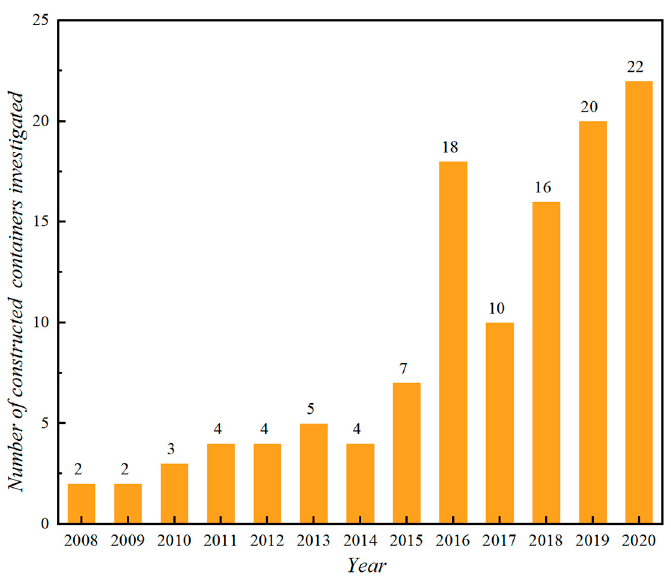
Figure 5. Annual construction statistics of investigated container project cases around China.